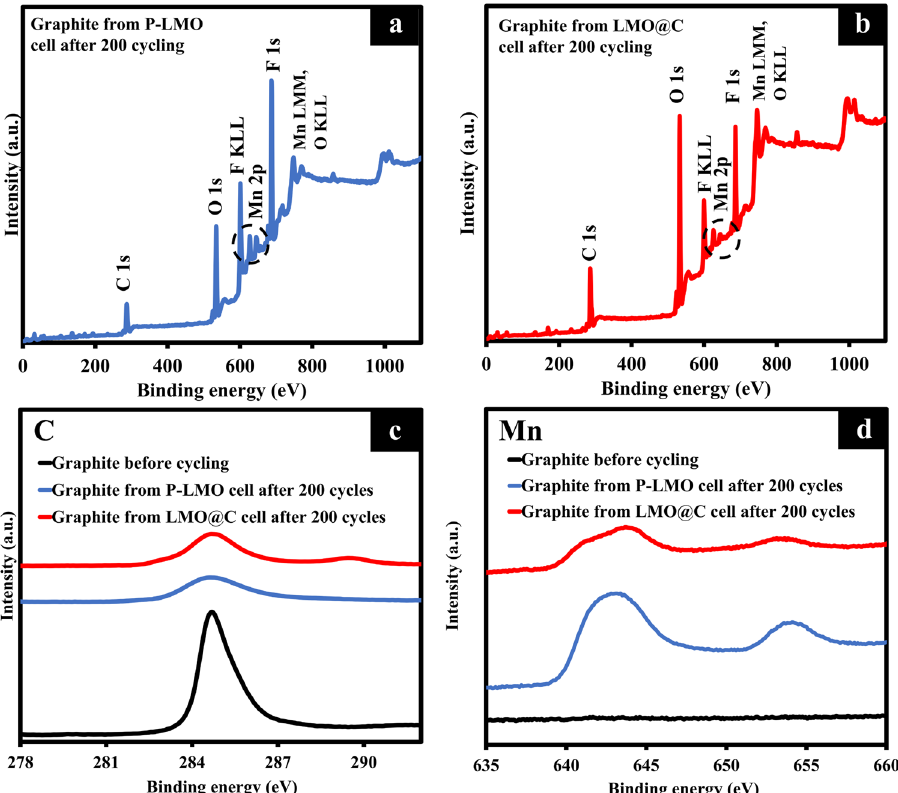
Fig. 5 Ex situ XPS of cathodes disassembled from P-LMO//graphite and LMO@C//graphite cells after cycling. a – b Wide-scan XPS of ( a ) P-LMO electrode, and ( b ) LMO@C electrode. c – d Narrow-scan XPS of ( c ) C 1 s orbitals, and ( d ) Mn 2p orbital of controlled graphite (before cycling), disassembled graphite from P-LMO//graphite and LMO@C//graphite cells after 200